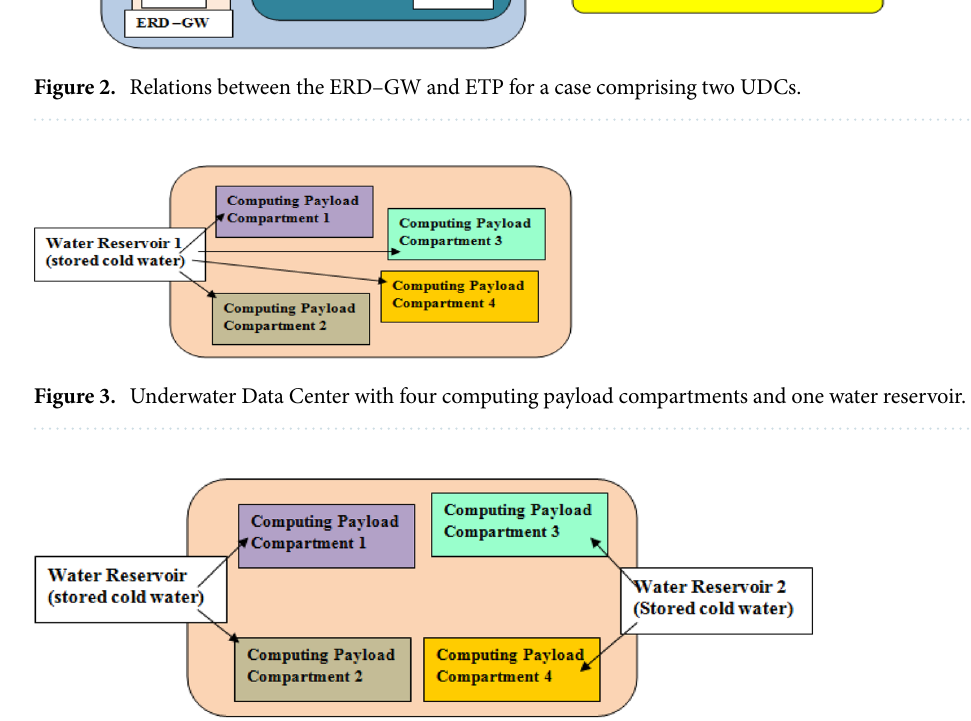
Figure 4. Underwater Data Center with four computing payload compartments and two water